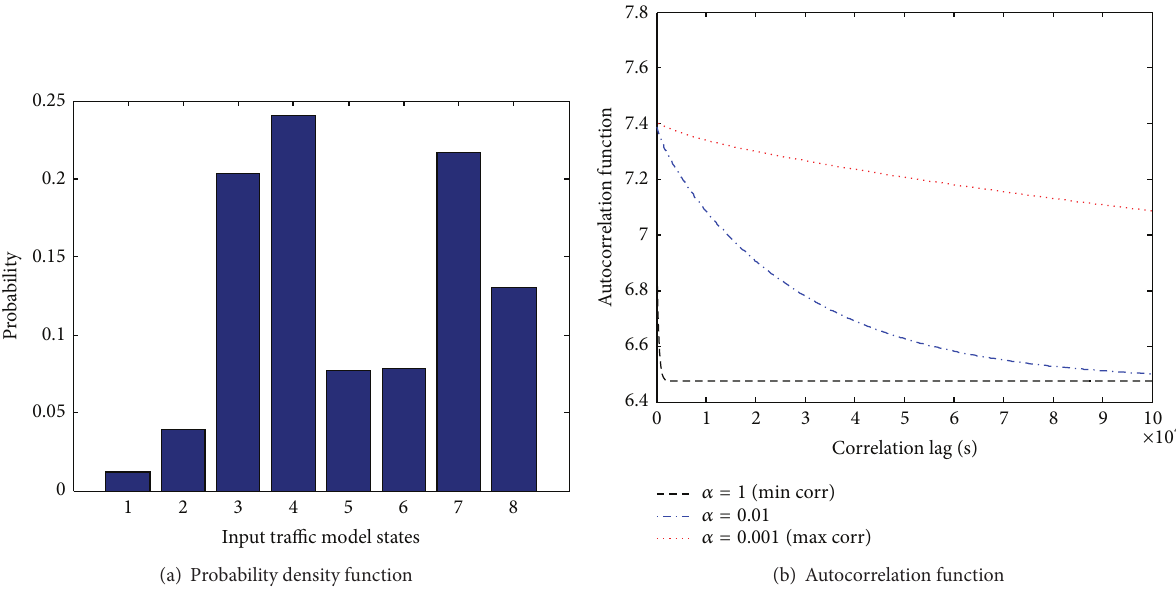
Figure 4: Input traffic first- and second-order statistics.